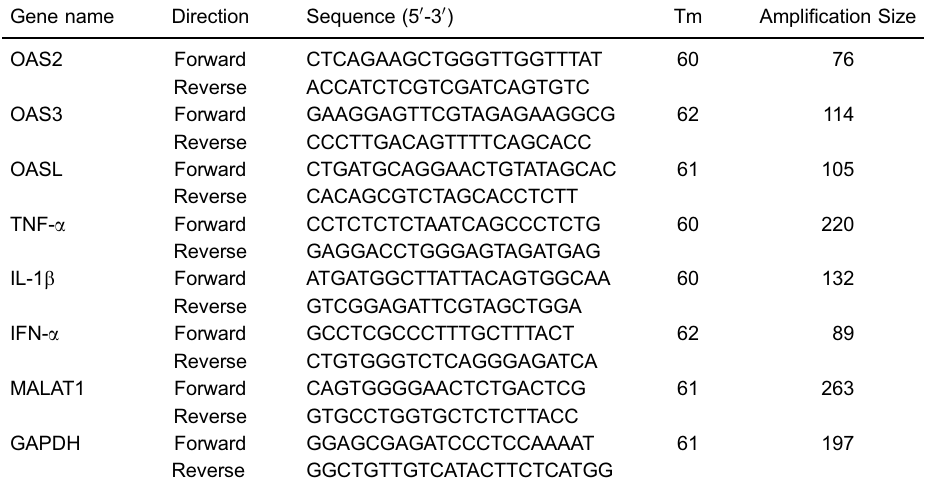
Table 3. Primers used for PCR